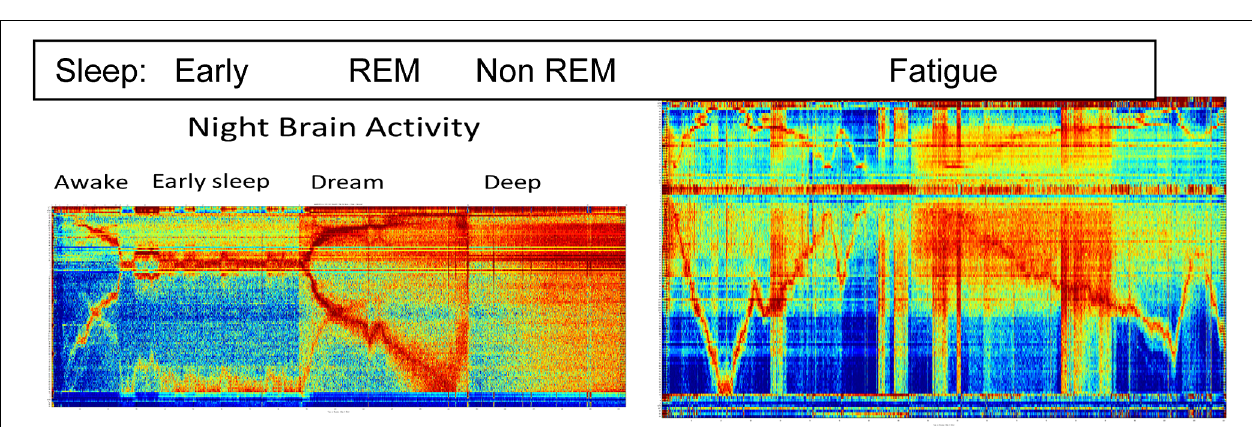
FIGURE 3 | Different brain activities features during sleep and Fatigue. See text for